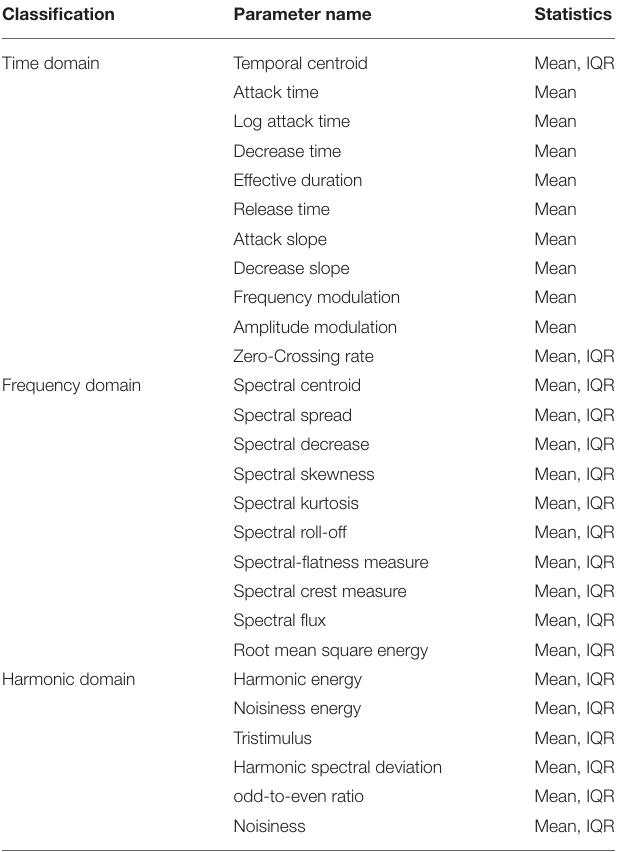
TABLE 4 | An acoustic parameter